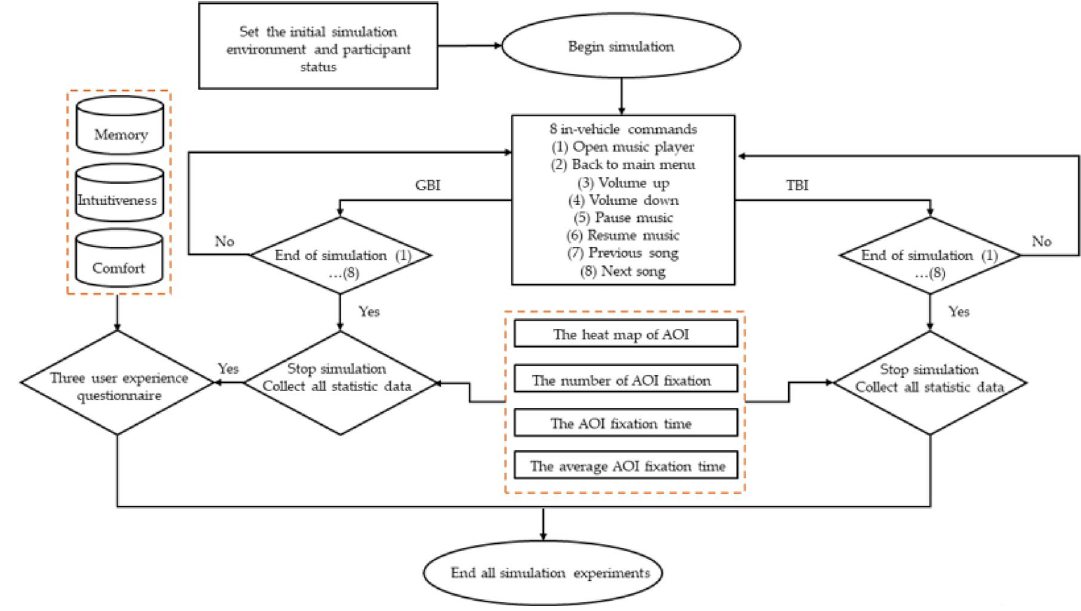
Fig. 5 The flowchart of eye movement